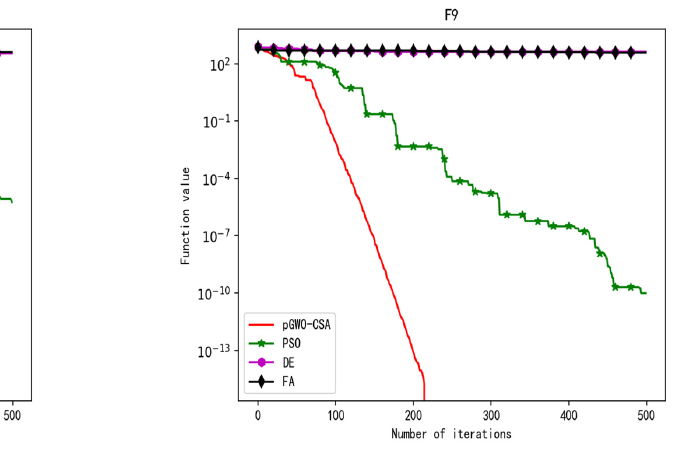
Figure 12. Convergence curve of test function F8.